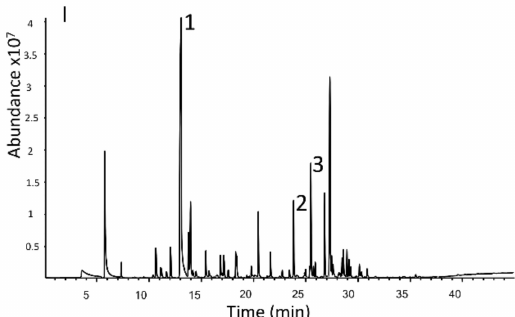
Figure 1. Total ion chromatogram of the volatile fraction of the nine hop cultivars obtained by the HS-SPME-GC-MS procedure. Chromatograms for cultivars; A = Riwaka, B = Rakau, C = Wai-iti, D = Nelson Sauvin, E = Wakatu, F = Kohatu, G = Waimea, H = Motueka, I = Taiheke. Compounds identified; 1 = β -myrcene, 2 = linalool, 3 =